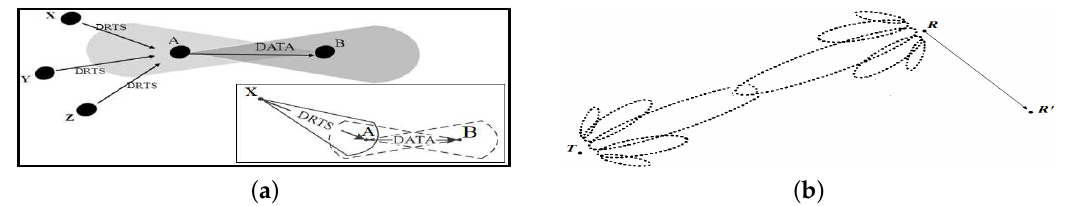
Figure 3. Directional antennas common issues in mobile ad hoc networks (MANETs). ( a ) Deafness